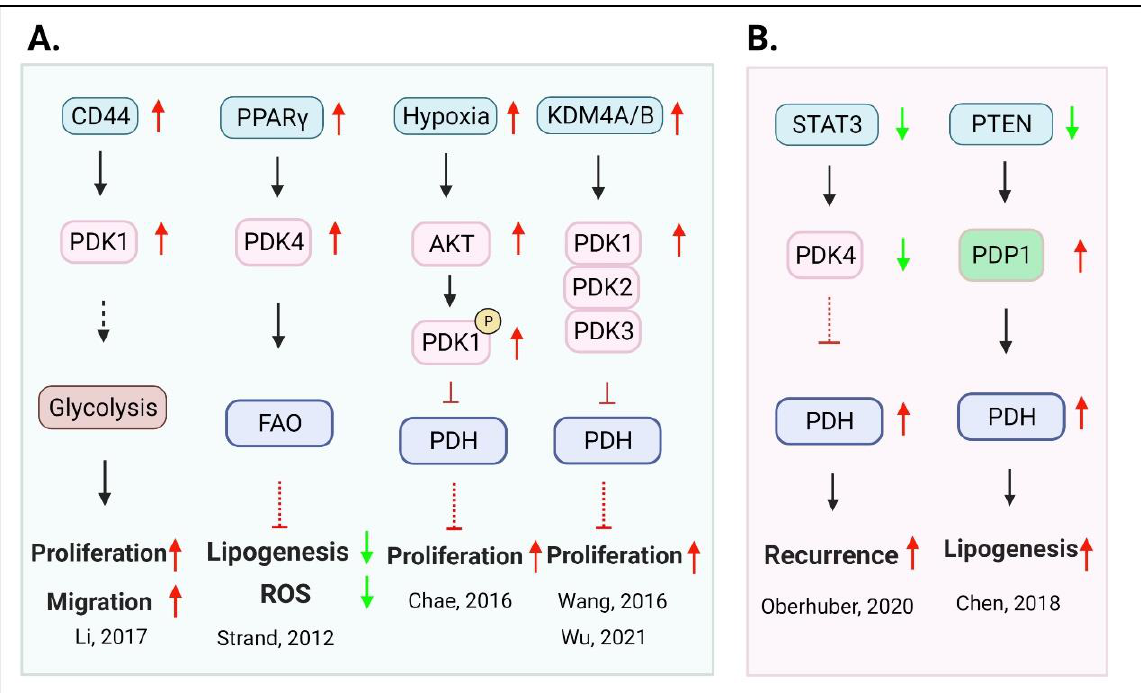
Figure 3. Duality of PDKs in PCa. ( A ) The high expression of PDKs regulated by CD44, PPARr, hypoxia, and KDM4A/B promotes PCa proliferation, migration in cell lines and xenograft models. ( B ) On the other hand, the low expression of PDK4 regulated by STAT3 leads to early recurrence and PCa lipogenesis by increasing PDH activity in clinical patient samples and transgenic PtenKO mouse model.